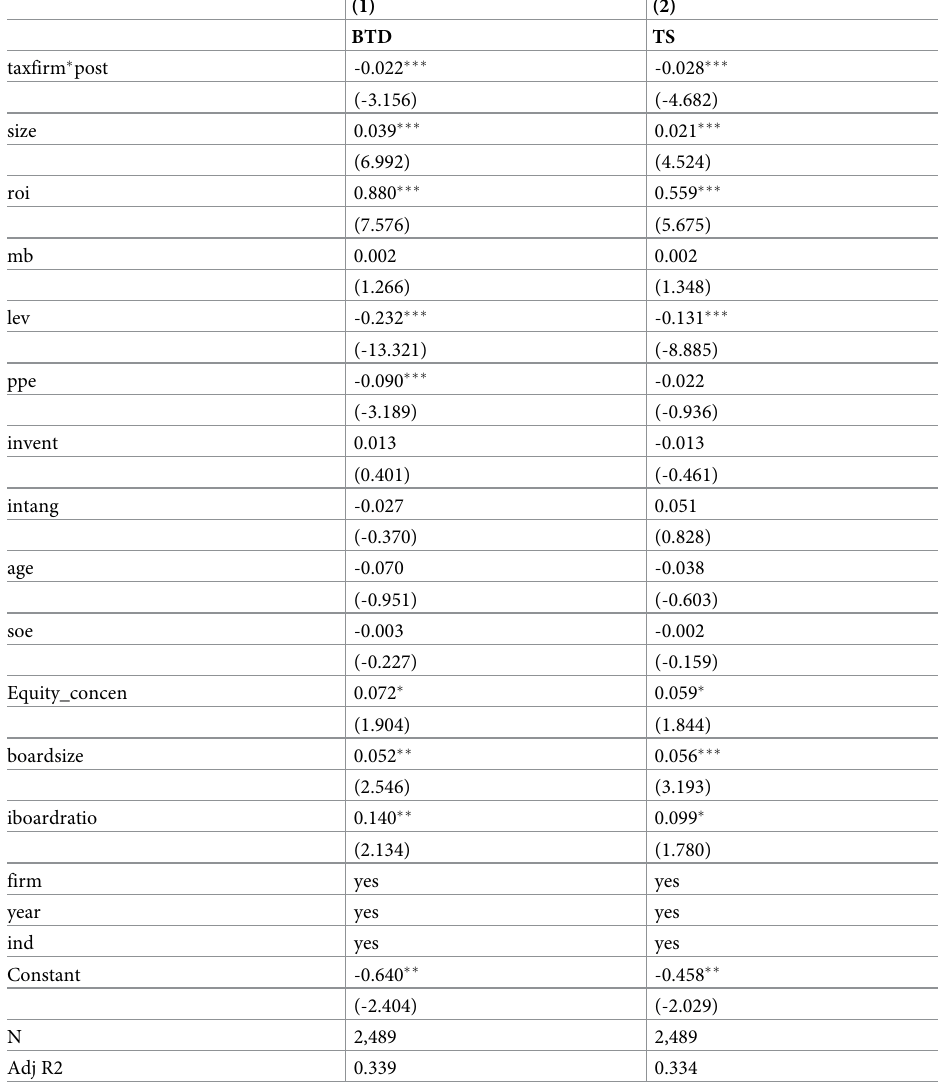
Table 5. The effect of tax-related comment letters on subsequent tax